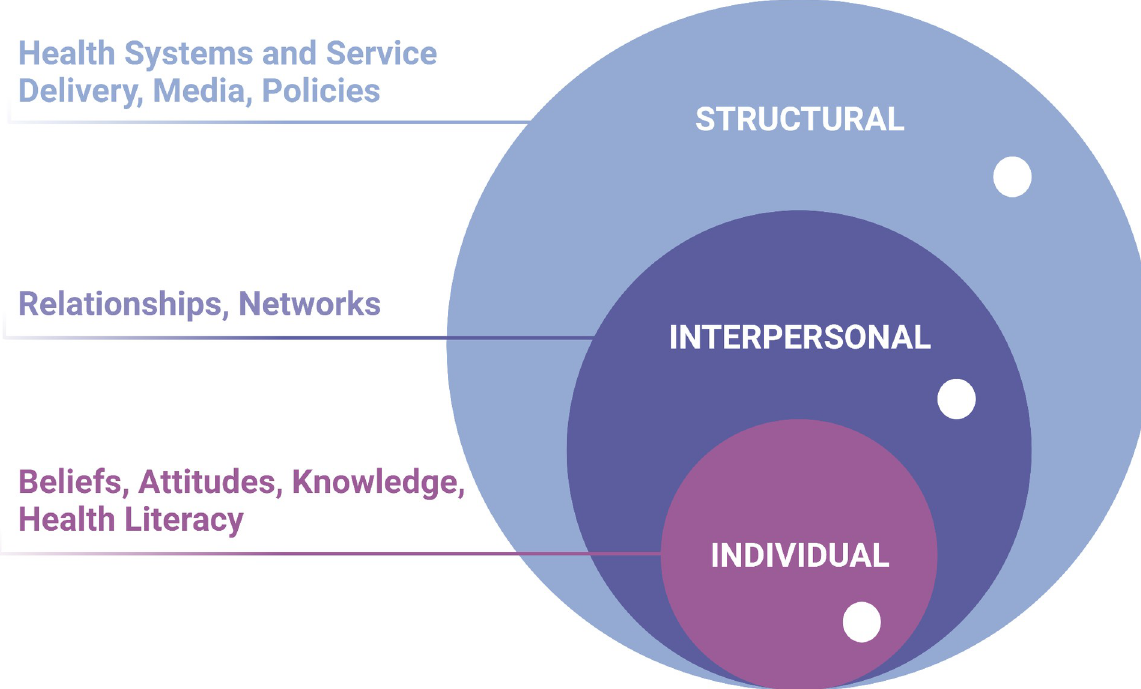
Fig 1. Social ecological model applied to COVID-19 vaccination. This figure shows the three main tiers of factors influencing vaccination intention and uptake: individual (beliefs, attitudes, knowledge, health literacy), interpersonal (relationships, networks), and structural (health systems and service delivery, media, policies). These three dimensions are jointly or individually impacted by misinformation (white